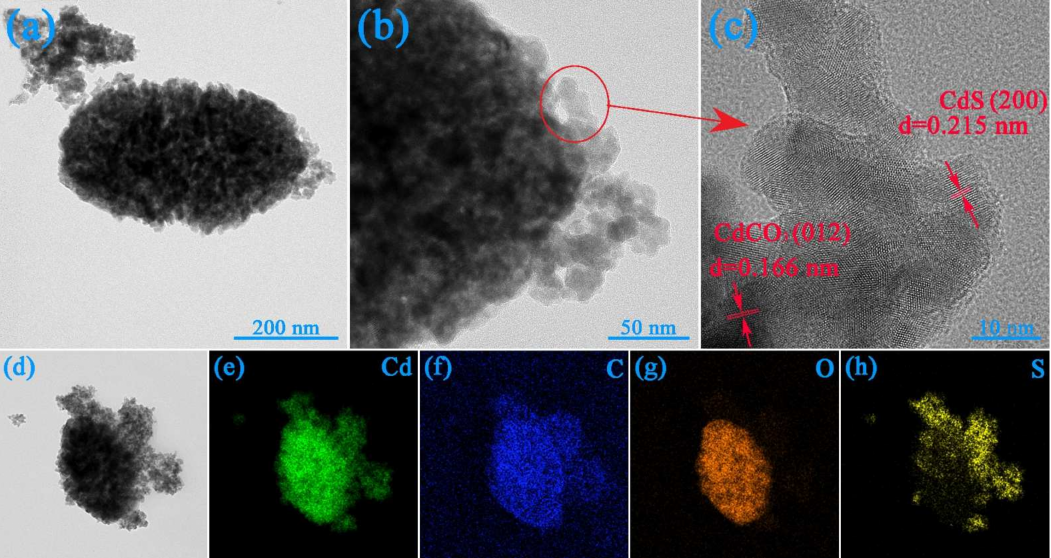
Figure 3. TEM of 5-CdS/CdCO 3 @SDS ( a – c ), HR-TEM and mapping elements ( d – h ).